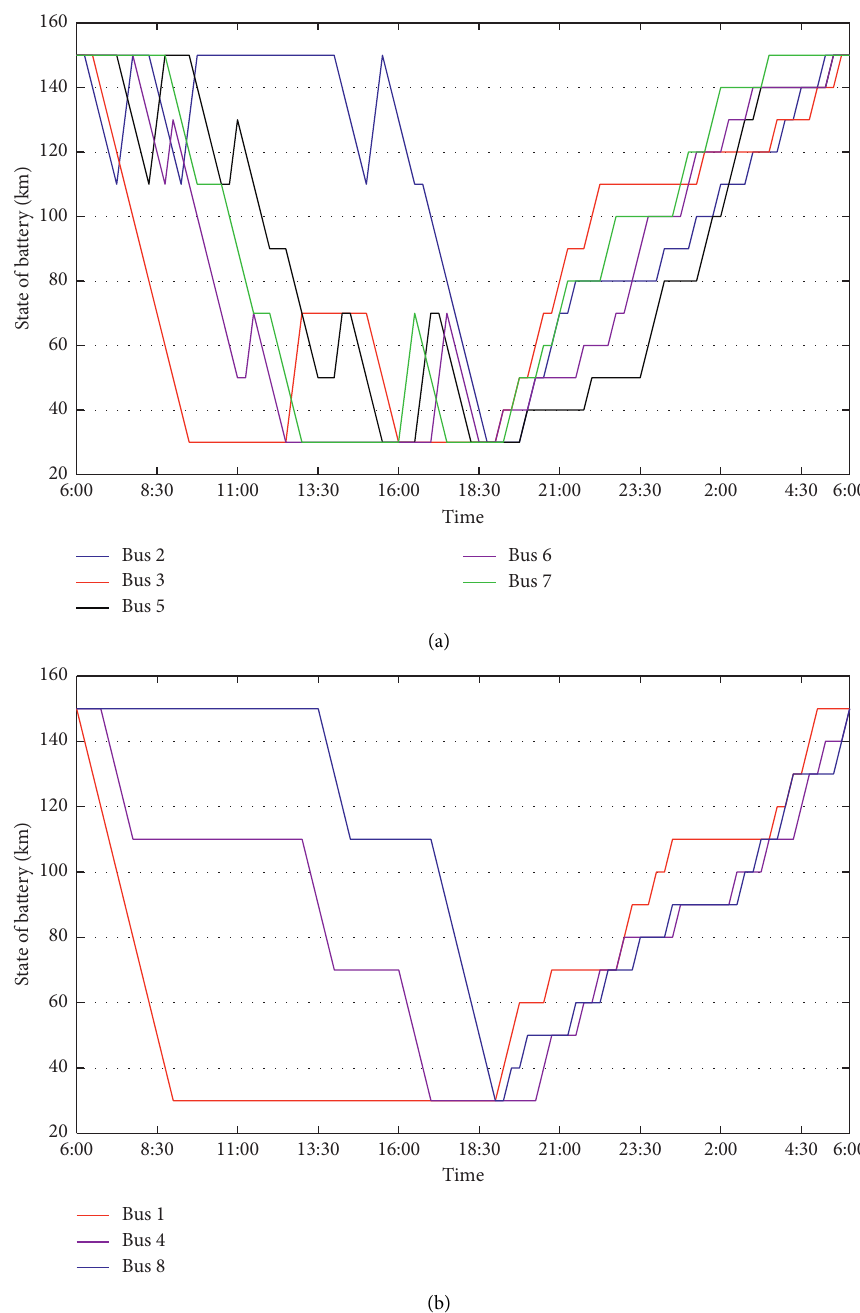
Figure 6: State of the battery for electric buses in each time